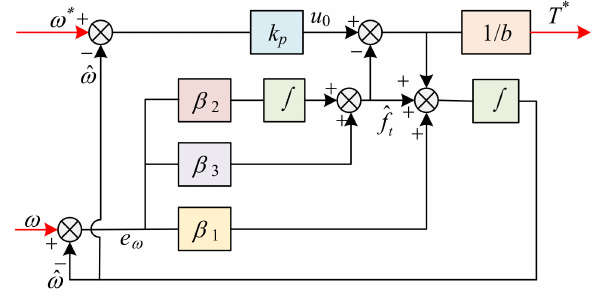
Figure 6. Structural diagram of